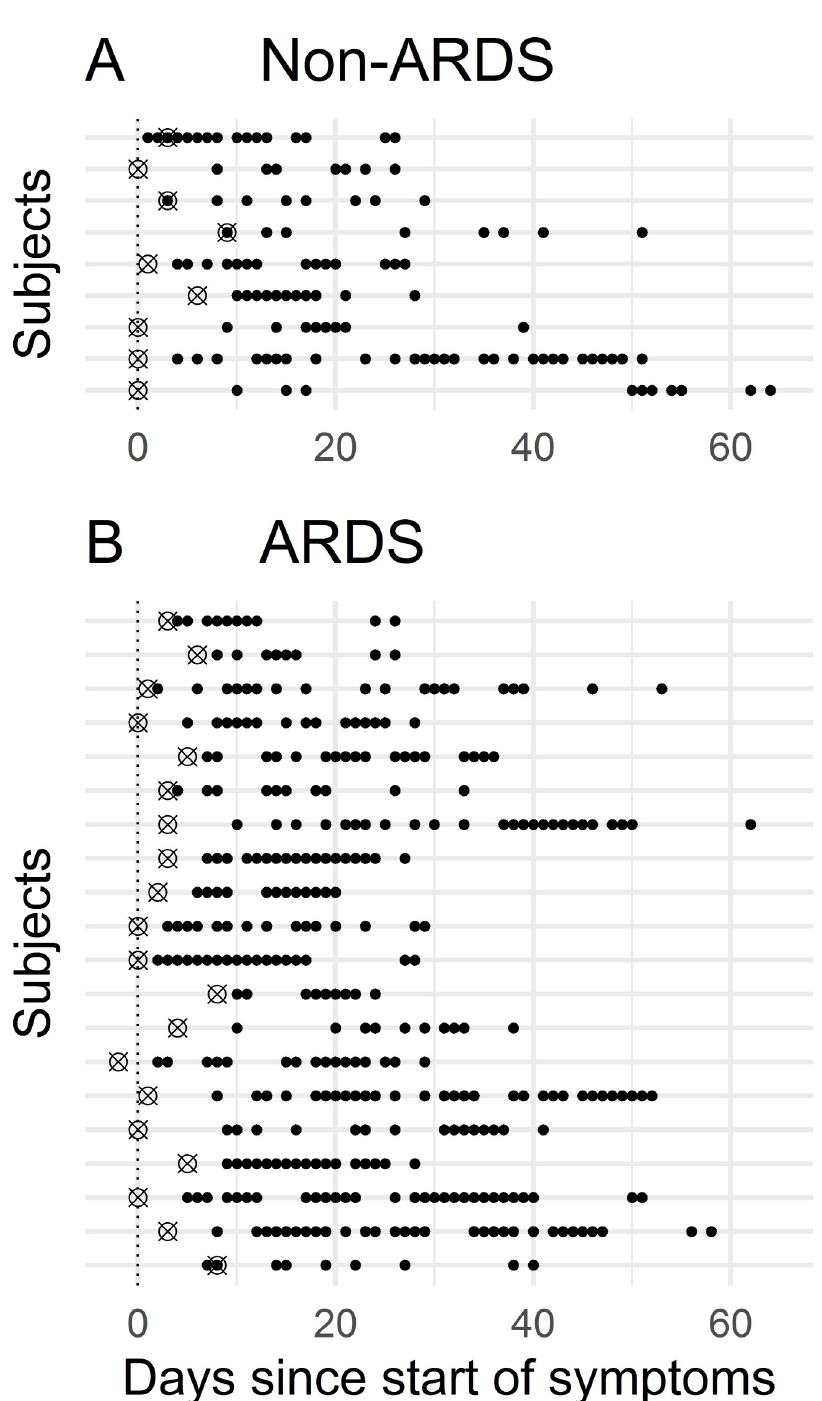
Fig 1. Time course of COVID-19 patient sampling. Day 0 represents symptom onset, crosses indicate the time of the first positive PCR result, dots indicate individual samples. (A) Non-ARDS patients. (B) ARDS patients.